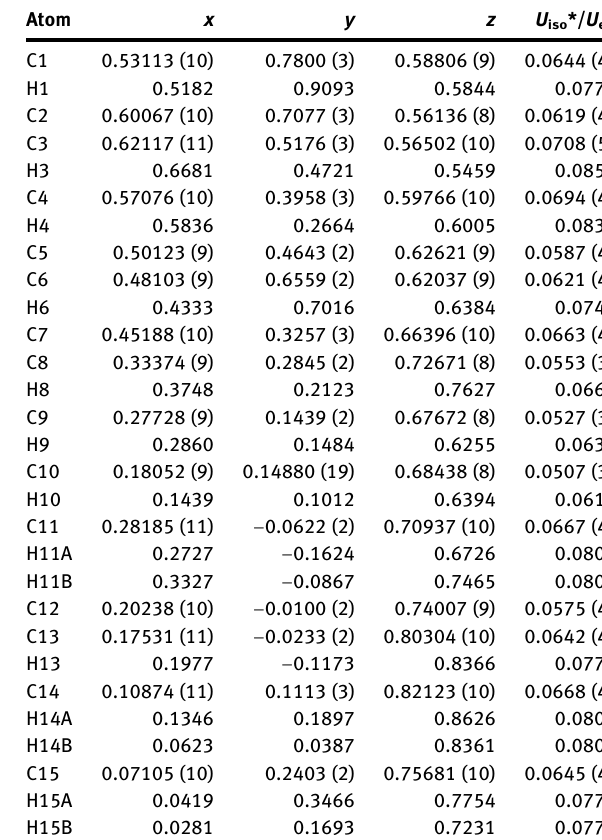
Table  : Fractional atomic coordinates and isotropic or equivalent isotropic displacement parameters (Å 